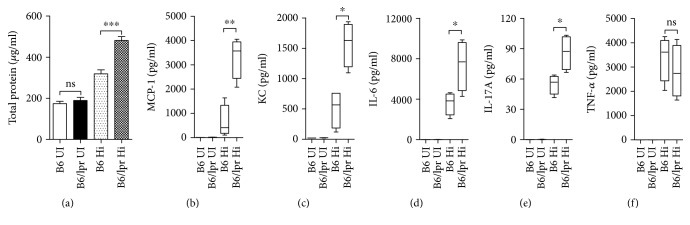
Infection induced heightened production of inflammatory cytokines in lupus-prone mice. B6 and B6/lpr mice were infected with Hi (B6 Hi and B6/lpr Hi). Uninfected mice were set as controls (B6 UI and B6/lpr UI). Two days after infection, all the mice were sacrificed and BALF was collected. (a) Protein levels were determined with the BCA assay. (b, c) Chemokines and (d–f) inflammation-related cytokines in the BALF were measured by ELISA. Data were expressed as means ± SEM. n = 3‐4 mice for each treatment group. ∗p < 0.05, ∗∗p < 0.01, and ∗∗∗p < 0.001. ns: no significant difference. This experiment is representative of three individual experiments.